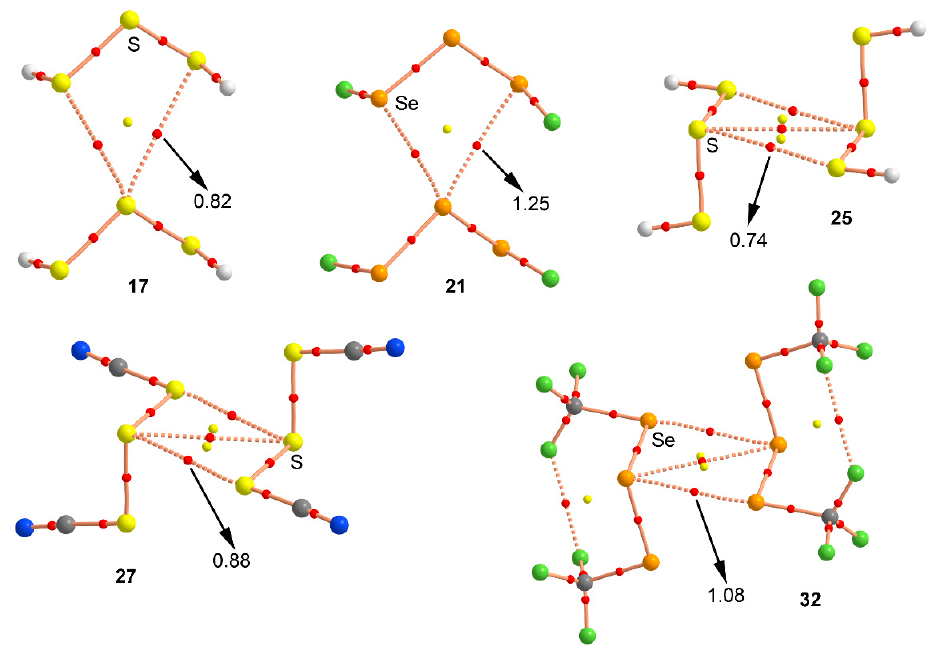
Figure 6. Distribution of critical points (red spheres) and bond paths for complexes 17 , 21 , 25 , 27 , and 32 at the MP2/def2-TZVP level of theory. Bond and ring CPs are represented by red and yellow spheres, respectively. The values of the charge density ( ρ ) at the bond critical points that emerge upon complexation are indicated in a.u.